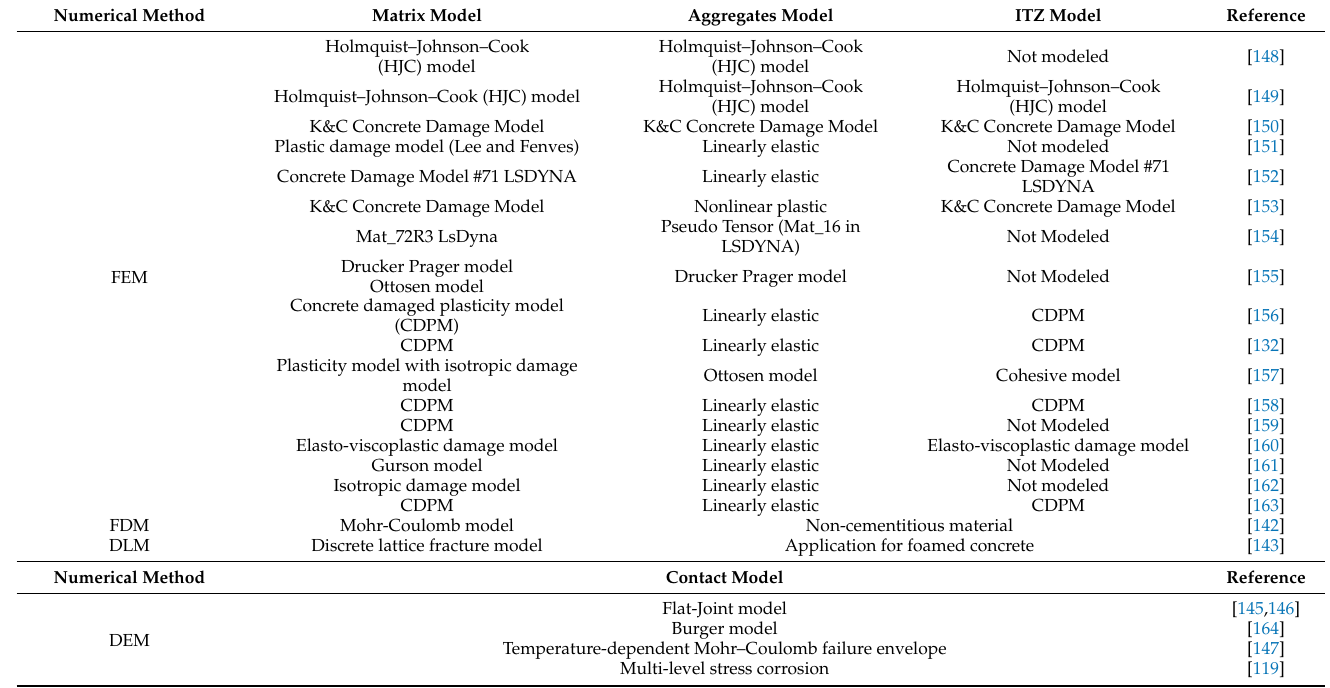
Table 3. Application of numerical methods with a focus on constitutive